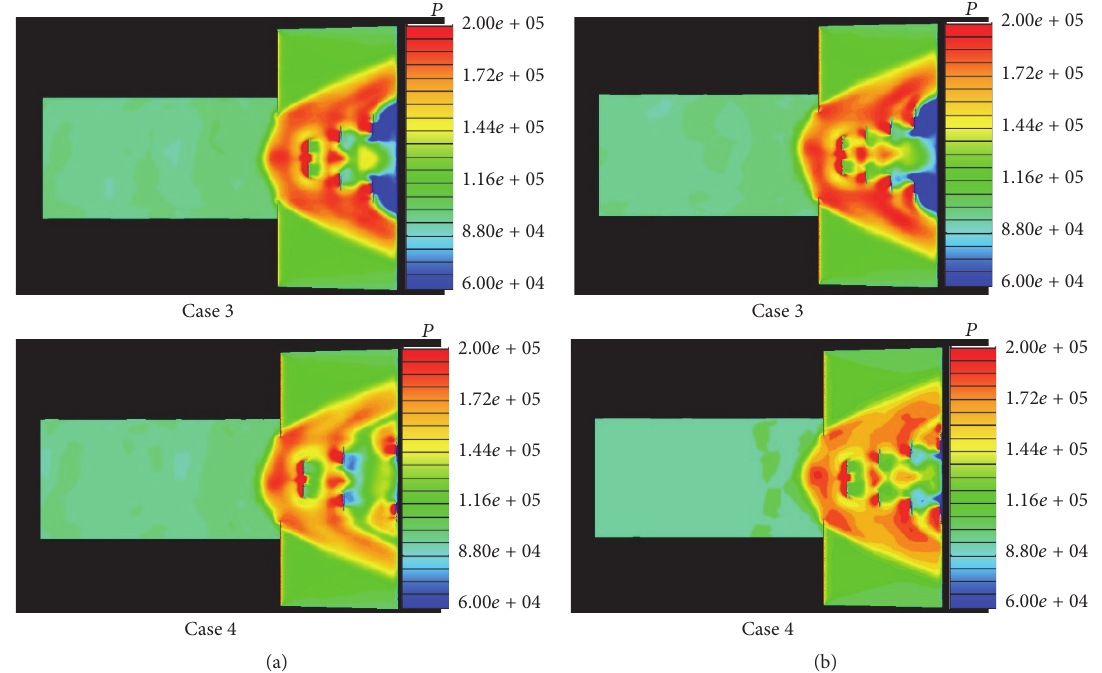
Figure 9: Computed surface pressure contours in the afterbody fin region near the microflaps, case 3 versus case 4, 𝑀 = 2.5, 𝛼 = 0 ∘ : (a) 6- and (b) 8-flap cases.